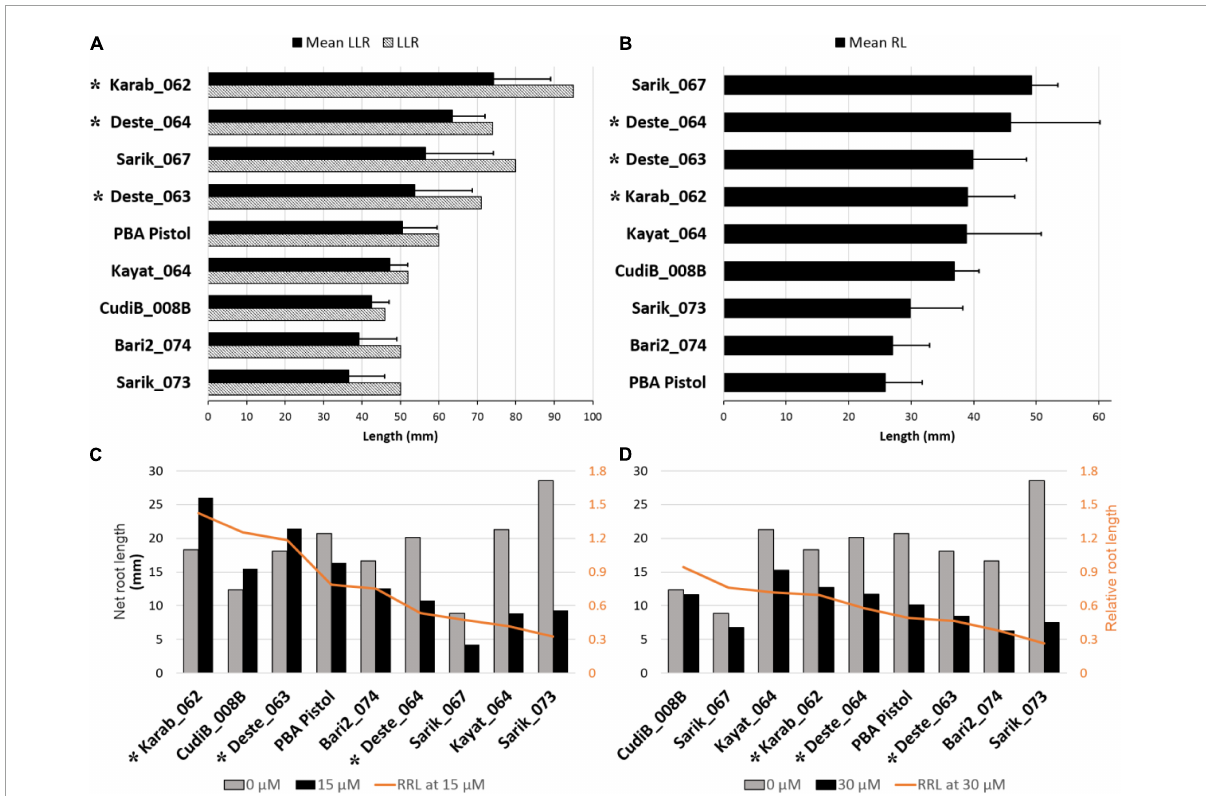
FIGURE1 Root length under control and Al treatment conditions for target chickpea accessions. (A) Longest Length of Root (LLR) before treatment. The bar chart was sorted (highest to lowest) by mean LLR of different treatments for different accessions. (B) Mean Root Length (RL) before treatment. (C) Net root length at 15 µ mol Al 3 + , and (D) 30 µ mol Al 3 + compared to the control condition (0 µ mol Al 3 + ). In graphs C and D relative root length (RRL) was calculated as: net root length at treatment/net root length at control. Plotting was sorted by RRL. (Error bar indicates standard deviation). * indicates the C. echinospermum